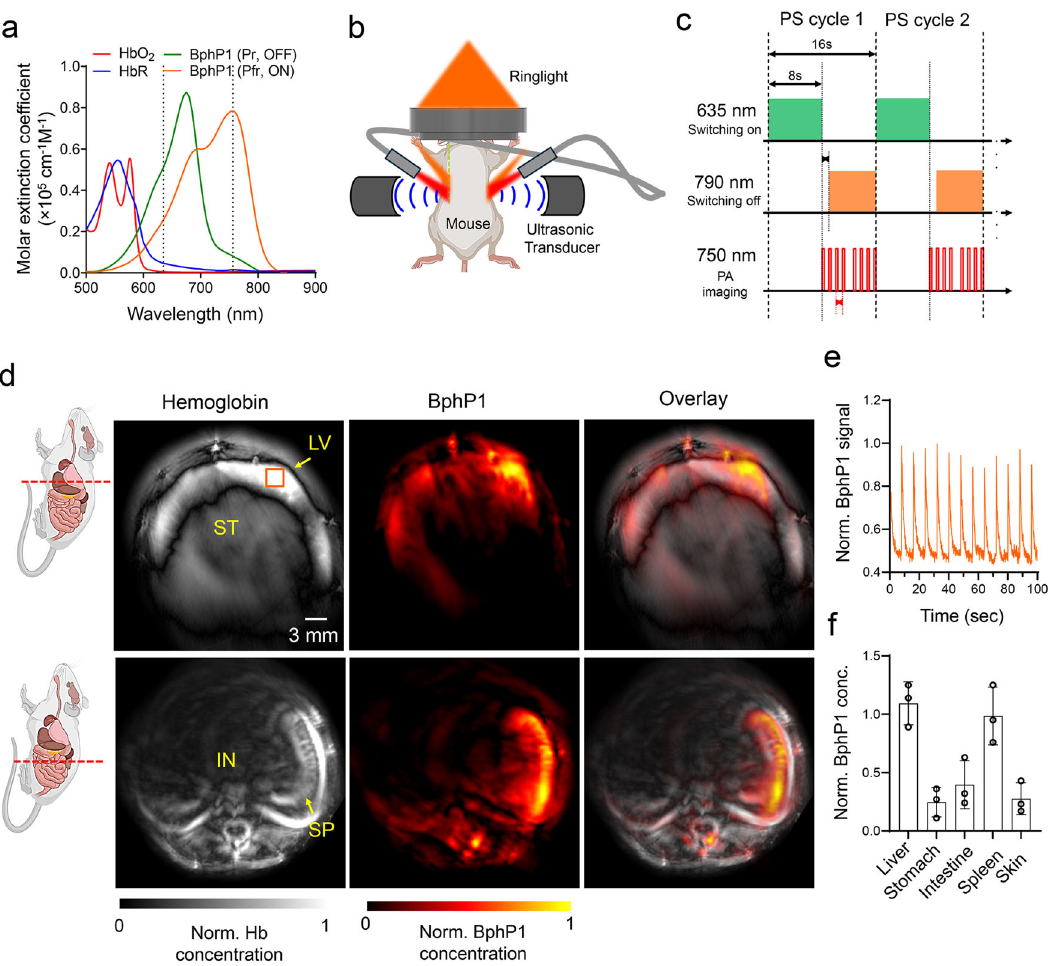
Fig. 5 Whole-body PA imaging of BphP1-Cre vasa mice. a Molar extinction coef fi cient spectra of oxy-hemoglobin (HbO 2 ), deoxy-hemoglobin (HbR), ON- state (Pfr) BphP1, and OFF-state (Pr) BphP1. While 635 nm light is used for switching ON BphP1, 750 nm light is used for PS imaging of and switching OFF BphP1. b The schematic of the deep PAT system with a ring-shaped ultrasound transducer array. The photoswitching light is delivered by fi ber bundles, and the PA imaging light is delivered via free space. c The time sequence of the photoswitching and PA imaging. Each cycle contains 8 s of switching-ON continuous-wave light at 630 nm, followed by 8 s of PA imaging at 750 nm. The switching-OFF continuous-wave light at 790 nm is turned on 6 s after the 750 nm light. Please note that the PA imaging light also contributes to switching off BphP1. d Differential PAT of the major organs of BphP1-Cre vasa mouse, showing the different BphP1 intracellular concentrations. IN, intestine; LV, liver; SP, spleen; ST, stomach. e The time courses of the BphP1 signals extracted from the liver, showing the reversible photoswitching. Please note that the photoswitching time was not included in the time course of PA imaging. f The relative BphP1 intracellular concentration in different organs, normalized by that in the liver. Data are presented as mean values + /- SD ( n = 3; independent imaging experiments). Source data are provided as a Source Data fi